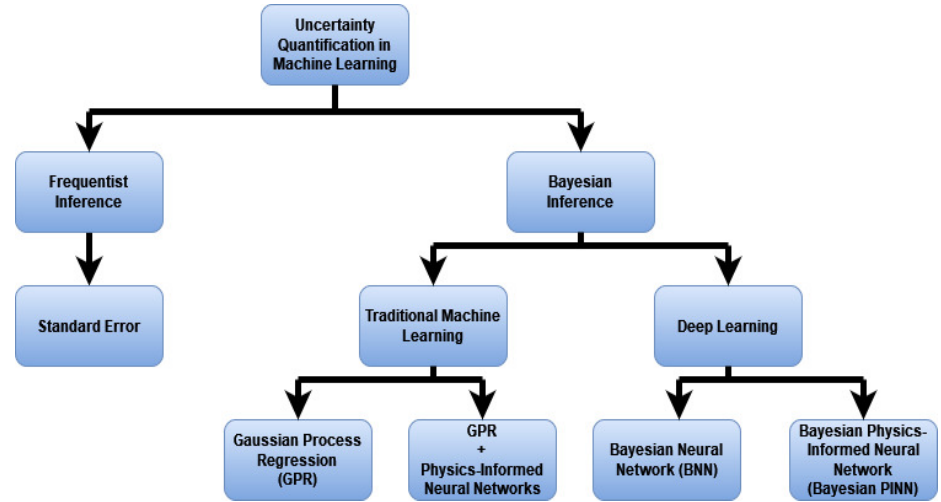
Figure 2. A graphical representation of uncertainty quantification models in machine